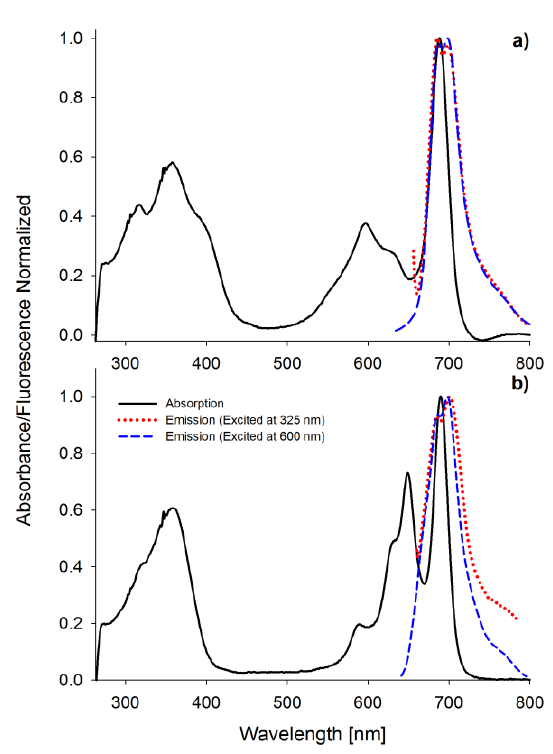
Figure 4. The UV-vis absorption and fluorescence spectra (excitation wavelength 325 and 600 nm) in DMF of 1 ( a ) and 2 ( b ).